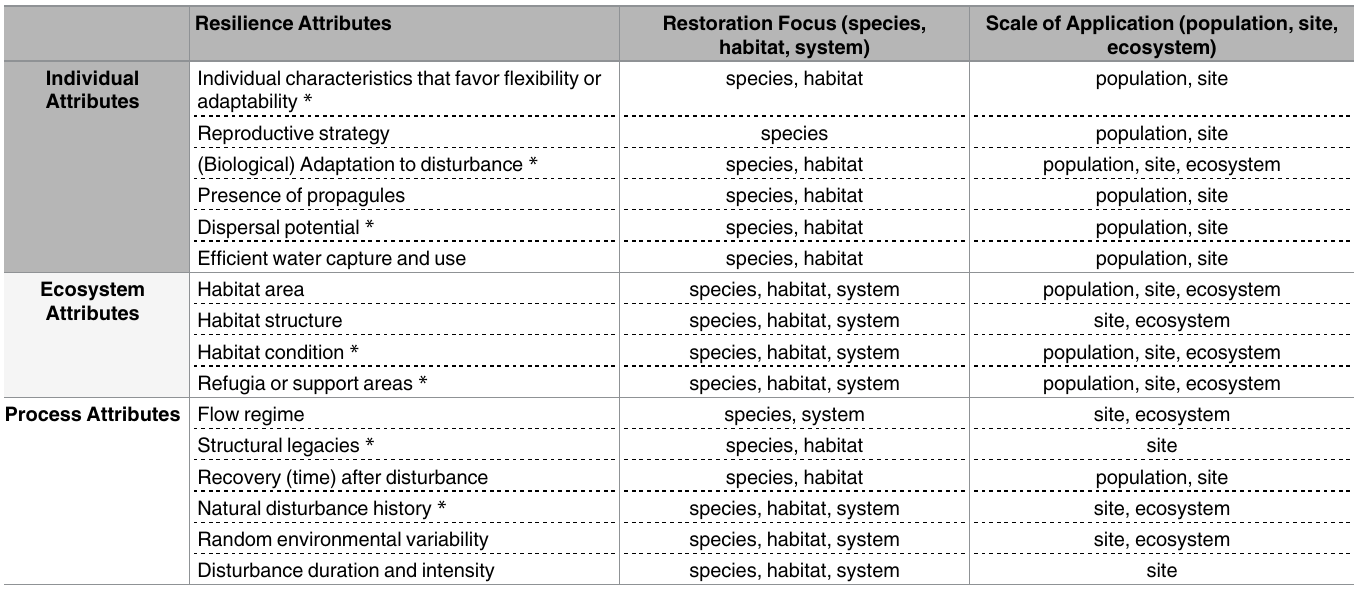
Table 5. Coral reef restoration